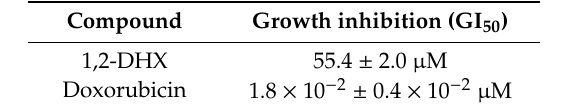
Table 1. Effect of 1,2-dihydroxyxanthone on the growth of the A375-C5 human melanoma cell line. Compound Growth inhibition (GI 50 )